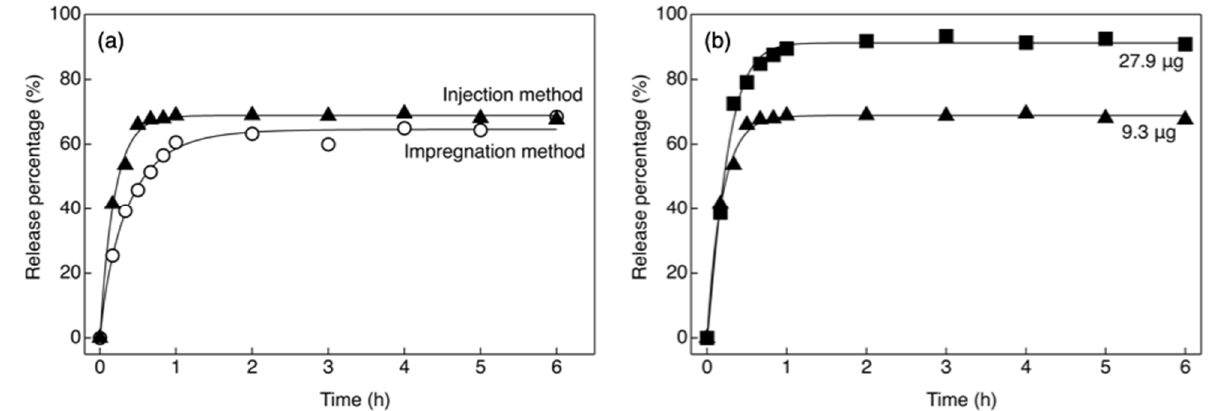
Figure 10. Release percentage of cytochrome C from ChG2 + HAp as a function of time: ( a ) impreg- nation and injection method; ( b ) different amount of cytochrome C loaded using injection method. Table 2. Weibull equation constants derived from Figure 10a. Table 3. Weibull equation constants derived from Figure